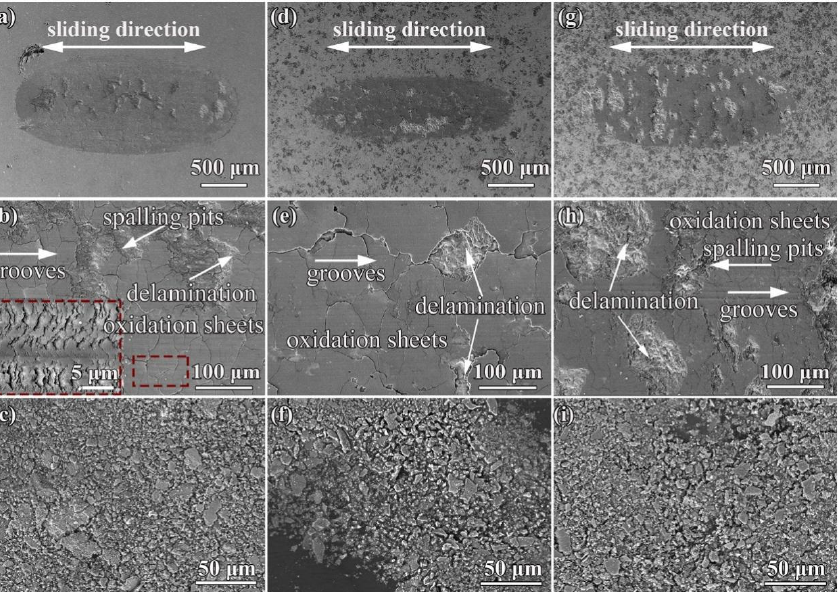
Figure 11. SEM images of the worn surface under 50 N: ( a – c ) CoCrFeMnNi HEA, ( d – f ) 10 wt%, ( g – i ) 20 wt% [103].